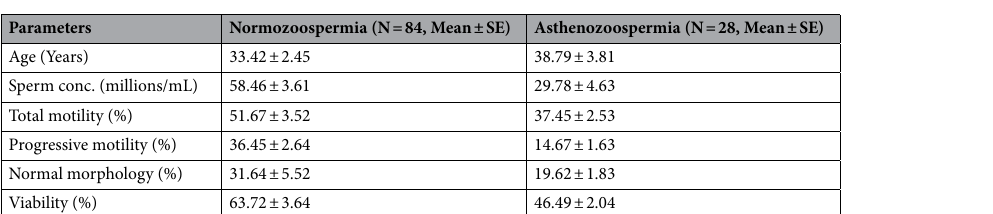
Figure 4. Interactions of pentoxifylline derivative PTXm-5 with PDEs at the end of MD simulations. Reversibly bound PTXm-5 (yellow stick) with ( a ) PDE4A, ( b ) PDE4D and ( c ) PDE10A. Target amino acid for covalent docking is shown as magenta stick. PTXm-5 (green) covalently bound to ( d ) C570 in PDE4A, ( e ) C358 in PDE4D and ( f ) S563 in PDE10A.